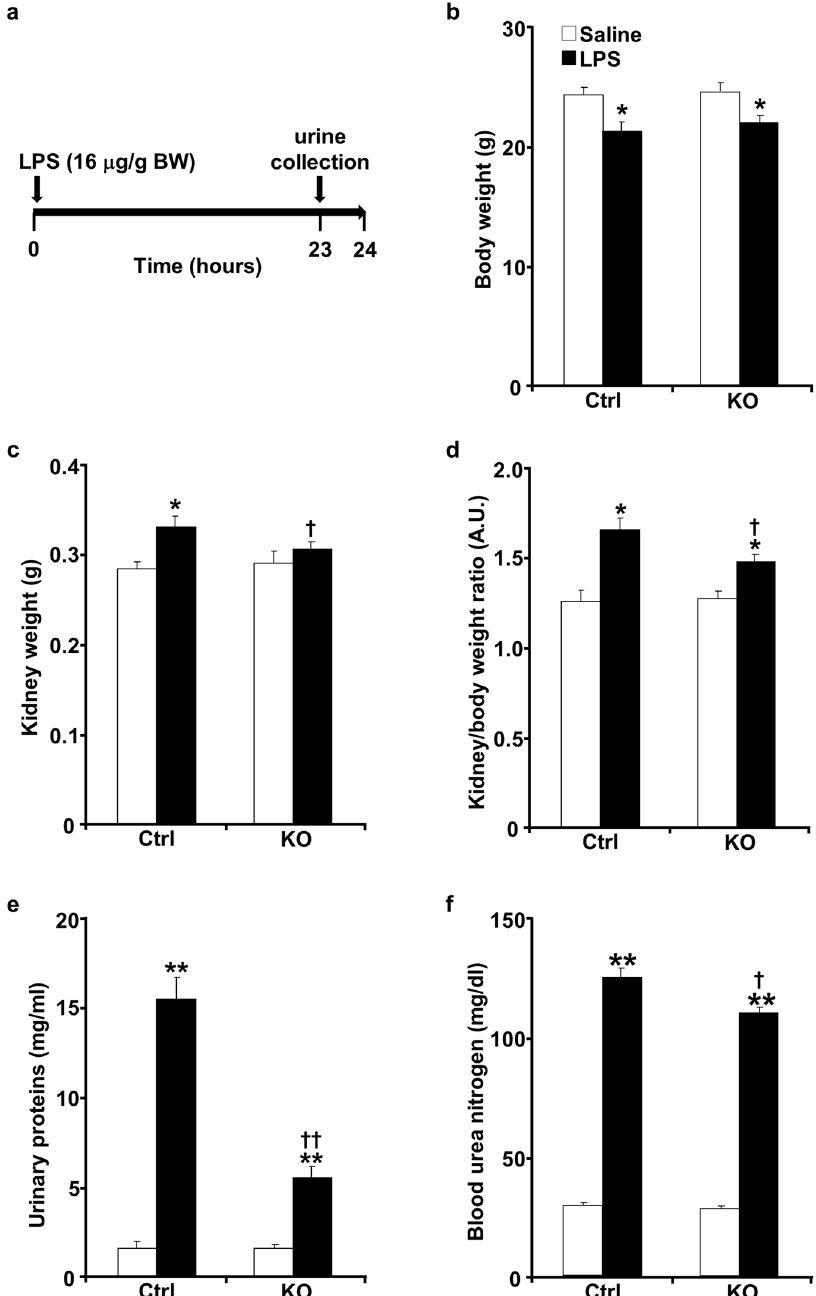
Figure 3. Pod-Shp2 KO mice are more resistant than controls to LPS-induced renal injury. ( a ) Schematic of experimental timeline for LPS administration and mice sacrifice. Body weight ( b ), kidney weight ( c ), kidney/ body weight ratio ( d ), urinary proteins concentration ( e ) and blood urea nitrogen ( f ) of control (Ctrl, n = 8) and pod-Shp2 knockout (KO, n = 8) mice without (saline) and with LPS treatment. * p < 0.05 and ** p < 0.01 indicate a significant difference between saline and LPS treatments; † p < 0.05 and †† p < 0.01 indicate a significant difference between Ctrl and KO mice. Data were presented as means + SEM. A.U., arbitrary